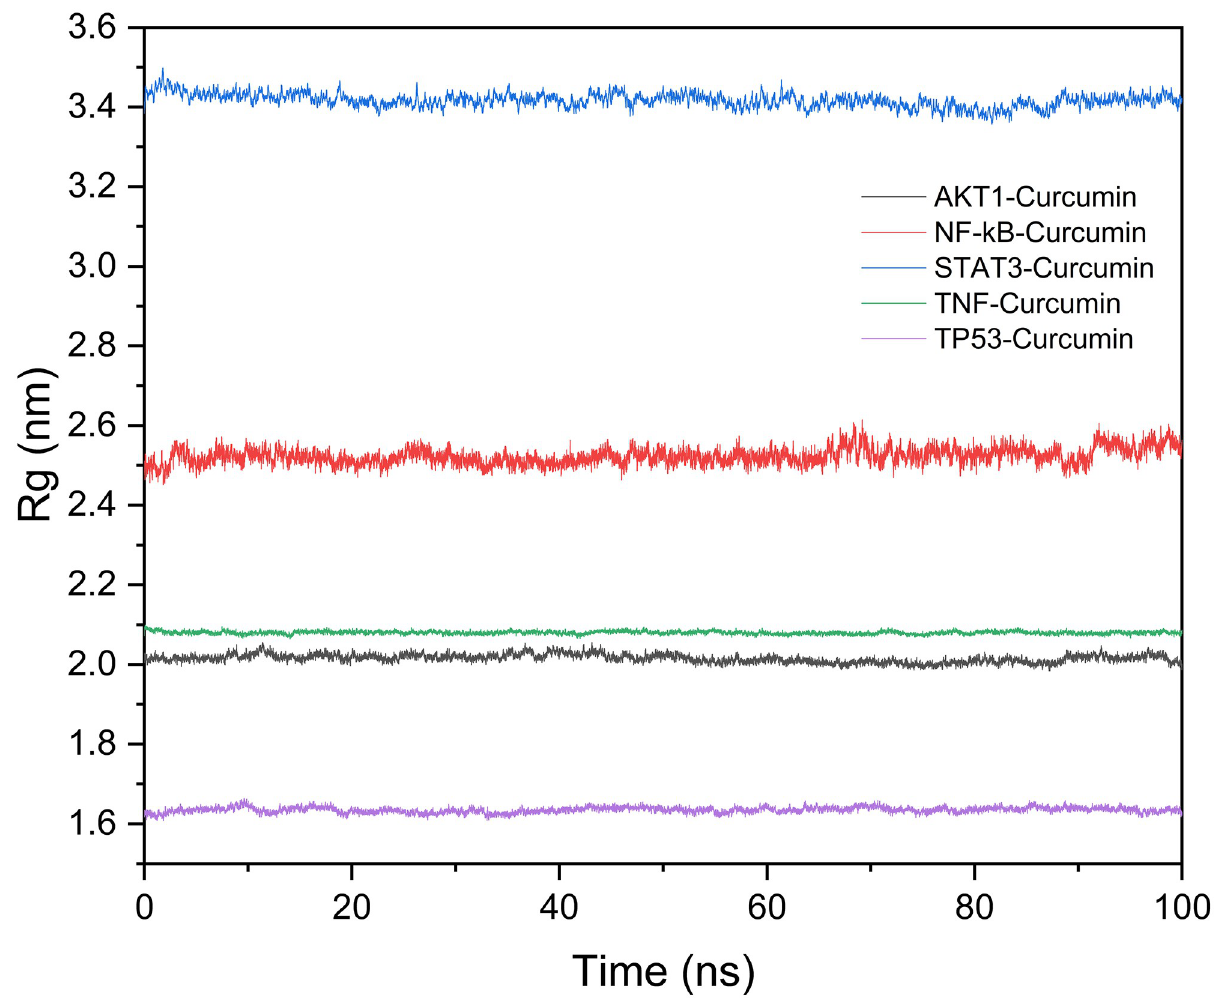
Fig 10. Compactness of the protein according to Rg.